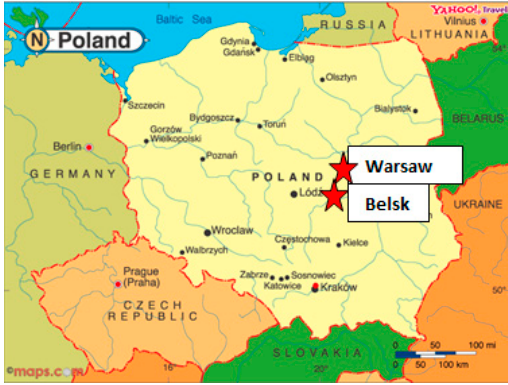
Figure 1. Location of monitoring stations.